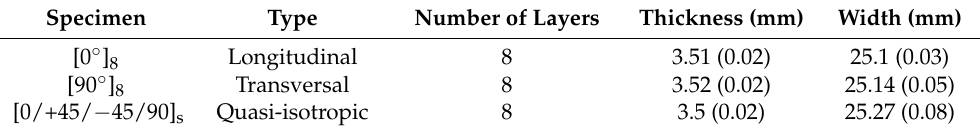
Table 2. The tested samples. The numbers in parenthesis represent the standard deviation.